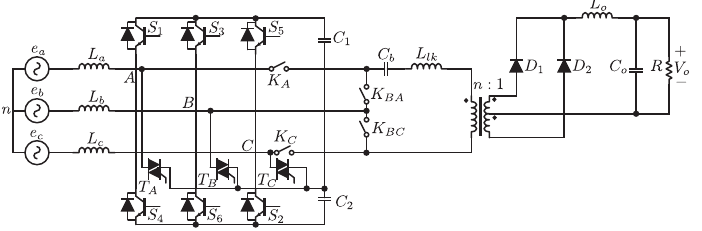
Figure 13. Fault-tolerant AC-DC single-stage isolated PEC. Combining T A , T B , T C TRIACs, and K A , K C , K BA , and K BC bidirectional switches, a faulty leg can be